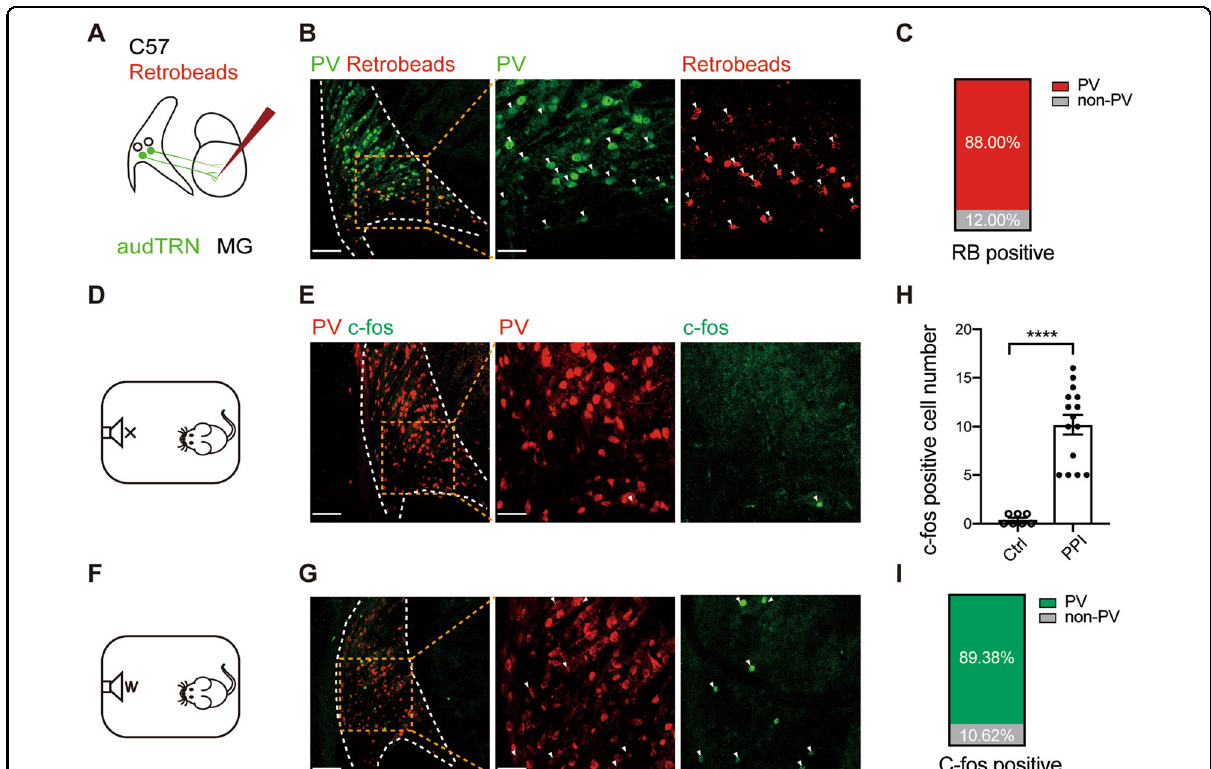
Fig. 1 PPI paradigm increases c-Fos expression of PV + neurons in audTRN. A Strategy of retrograde labeling of audTRN neurons projecting to MG. Retrobeads (RBs) were injected into MG of C57 mice. B Left, example of confocal image showing overlap of retrobeads-labeled neurons(red) and PV-positive neurons (green). White dotted lines mark the border of the TRN. Middle and right, enlarged images from the yellow box region in the left image. Arrows: dual-positive neurons. Scale bars: left to right, 100 µm, 40 µm. C Quanti fi cation shows that approximately 88.0% of RBs labeled cells are PV + ( N = 7 slices of 3 mice). D , F Schematic of the behavioral test before c-Fos staining experiment. C57 mice were put into the startle re fl ex chamber without sound stimulation ( D , control group), or with prepulse inhibition (PPI) paradigm ( F , PPI group). E , G Left, example of confocal image showing overlap of c-Fos-positive neurons and PV-positive neurons of control group ( E ), or PPI group ( G ). White dotted lines mark the border of the TRN. Middle and right, enlarged images from the yellow box region in the left image. Arrows: dual-positive neurons. Scale bars: left to right, 100 µm, 40 µm. H PPI paradigm increased c-Fos-positive neuron number compared with the control group (Mann – Whitney two-tailed t -test, P < 0.0001, N control = 7 slices of 3 mice, N PPI = 15 slices of 6 mice). I Quanti fi cation shows that approximately 89.38% of c-Fos-positive cells are PV + ( N = 15 slices of 6 mice, PPI group). **** P <